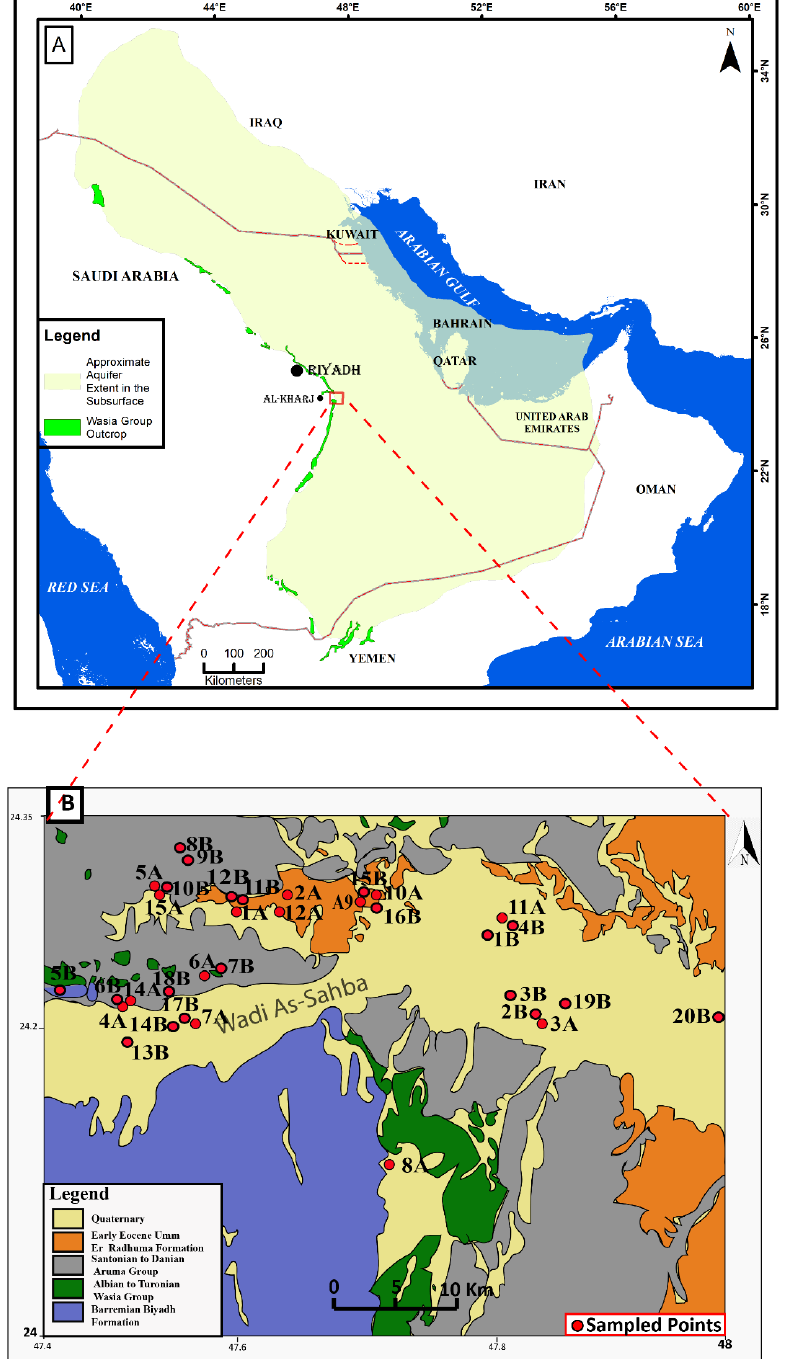
Figure 1. ( A ) A map of the Arabian Peninsula showing the location of the surface outcrop of the Cretaceous Wasia and the regional extent of the Wasia aquifer in the subsurface (modified from Reference [12,16]). ( B ) A geological map of the Al Kharj area in Central Saudi Arabia with sampling points of supply water wells from the present study. A wadi is a valley, ravine, or channel that is dry except in rainy